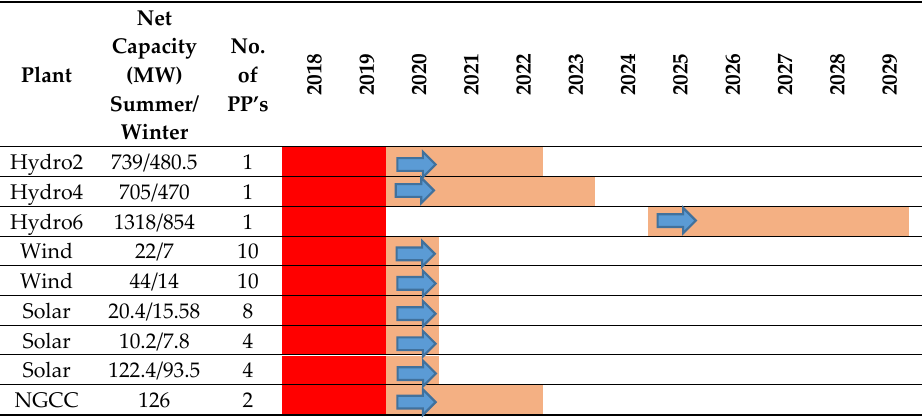
Table A3. Details of the Plants Installation under Capacity Expansion: Low GDP Fuel Balancing (3–30% Mitigation).